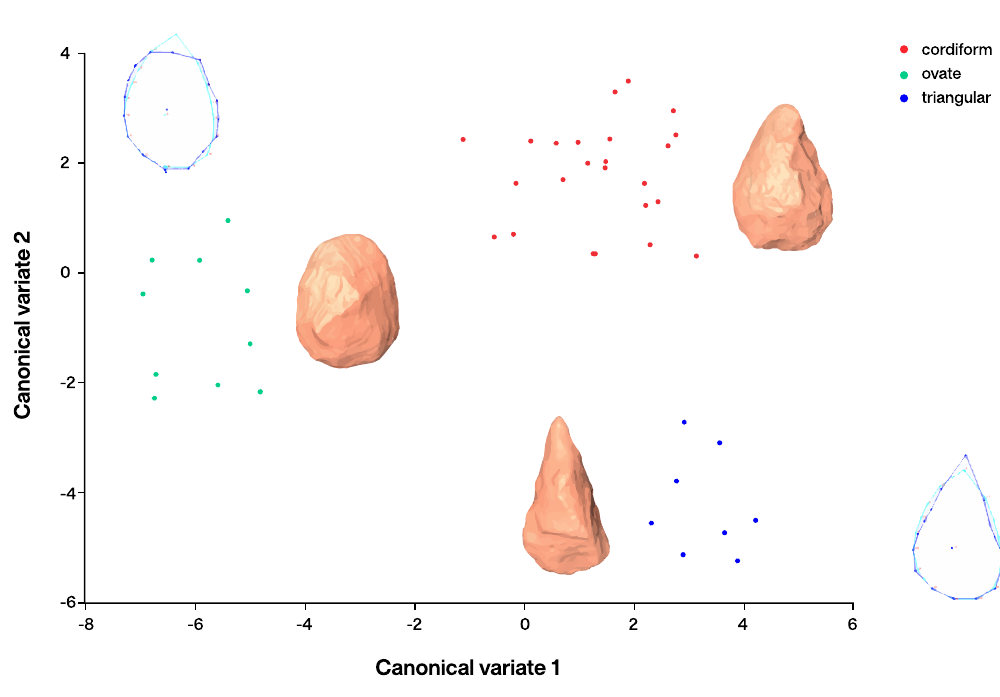
Figure 4. Canonical Variates Analysis of Biface form (n = 50) at An Nasim, showing discrete shape groupings corresponding to triangular, ovate and cordiform forms. See Tables S2–S4 for eigenvalues and